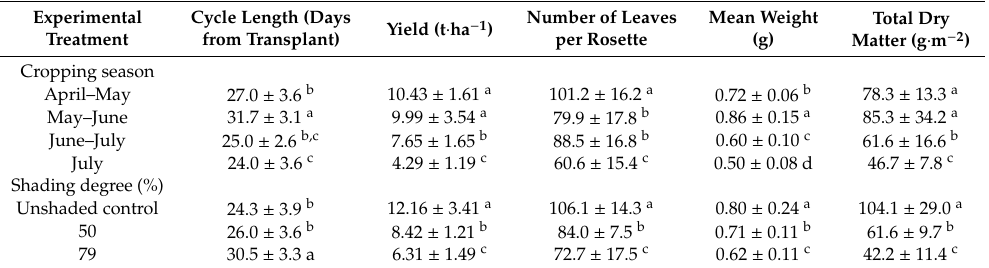
Table 1. Rocket yield and dry matter content as a ff ected by cropping season and shading degree. Experimental Treatment